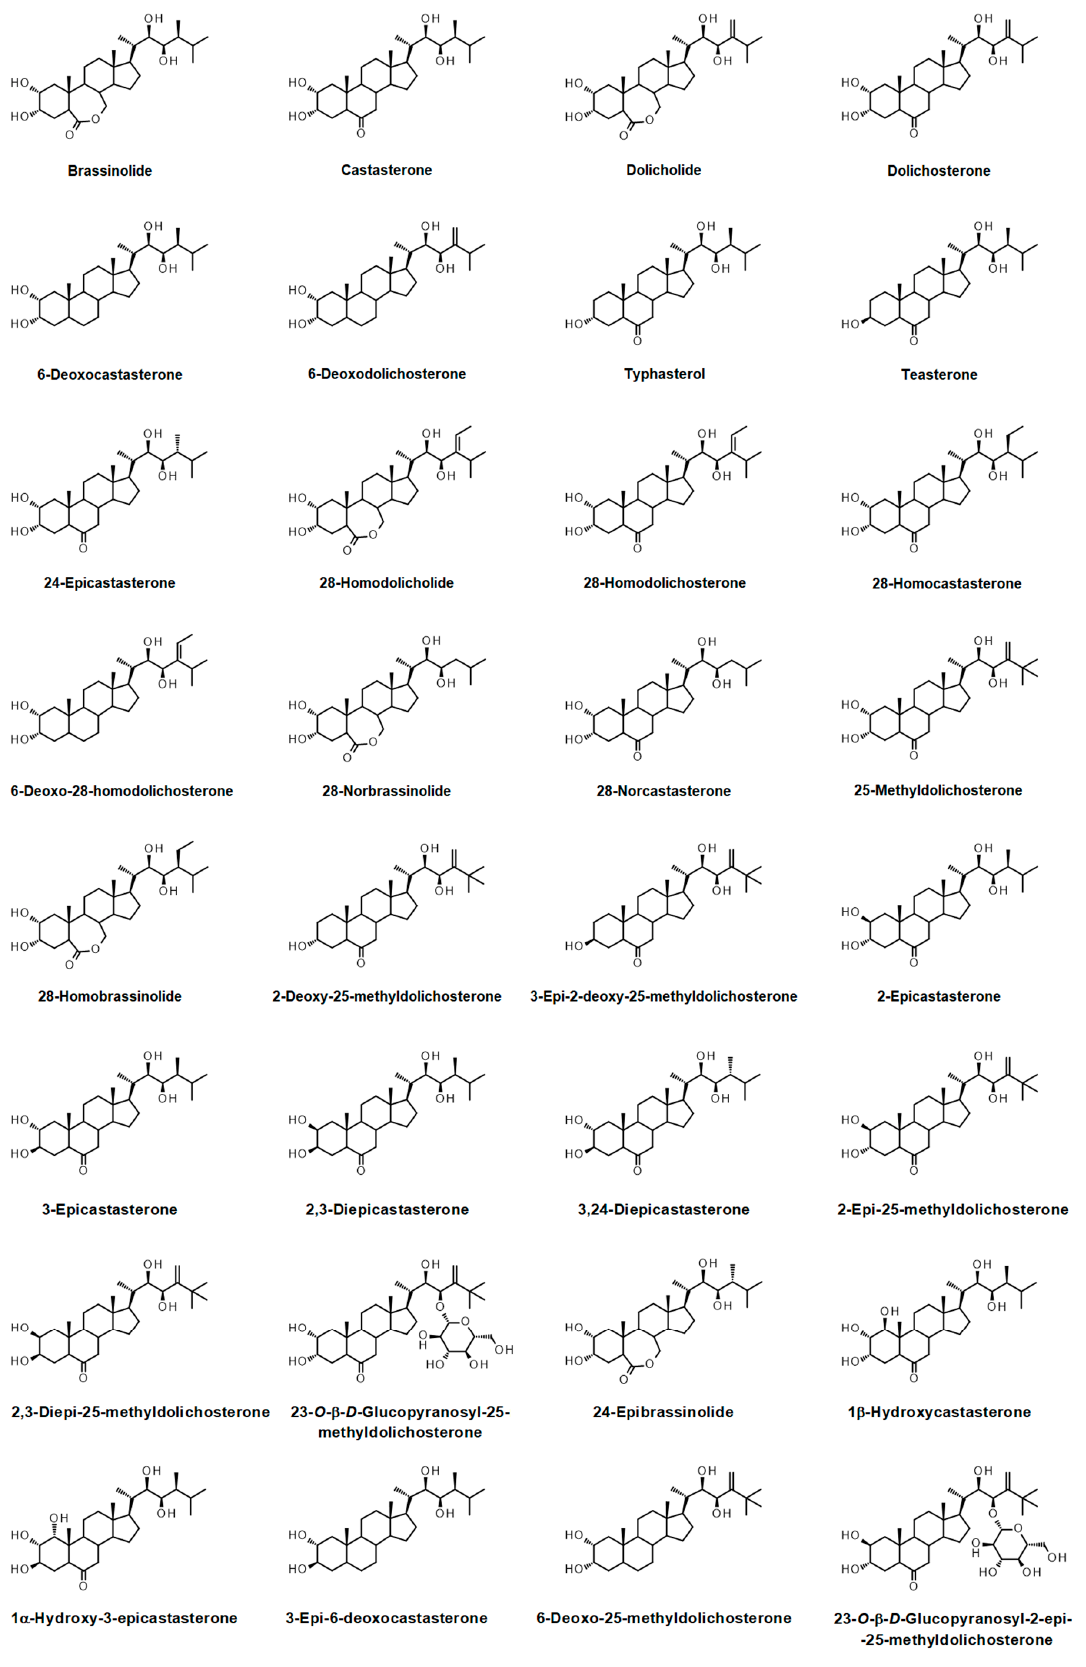
Figure 1. Natural brassinosteroids isolated from or detected in plant sources. Figure 1. Cont